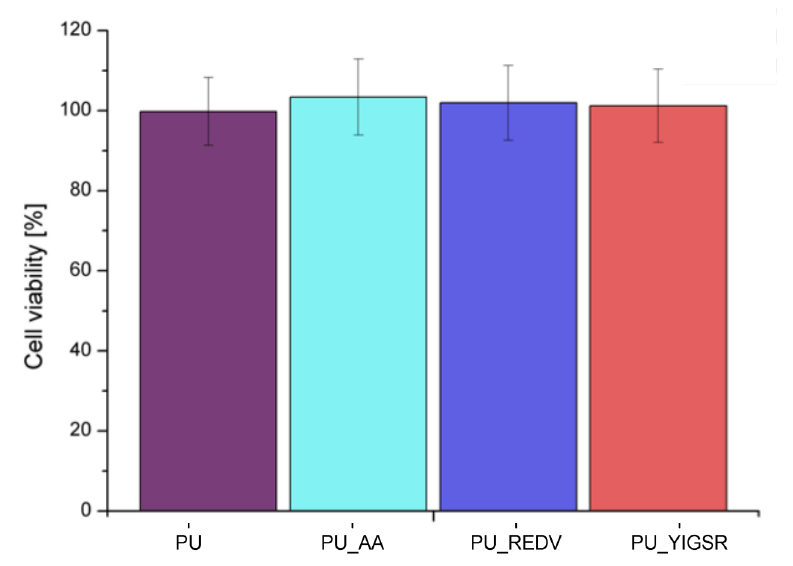
Figure 7. Cell viability (MV ± SD, n =